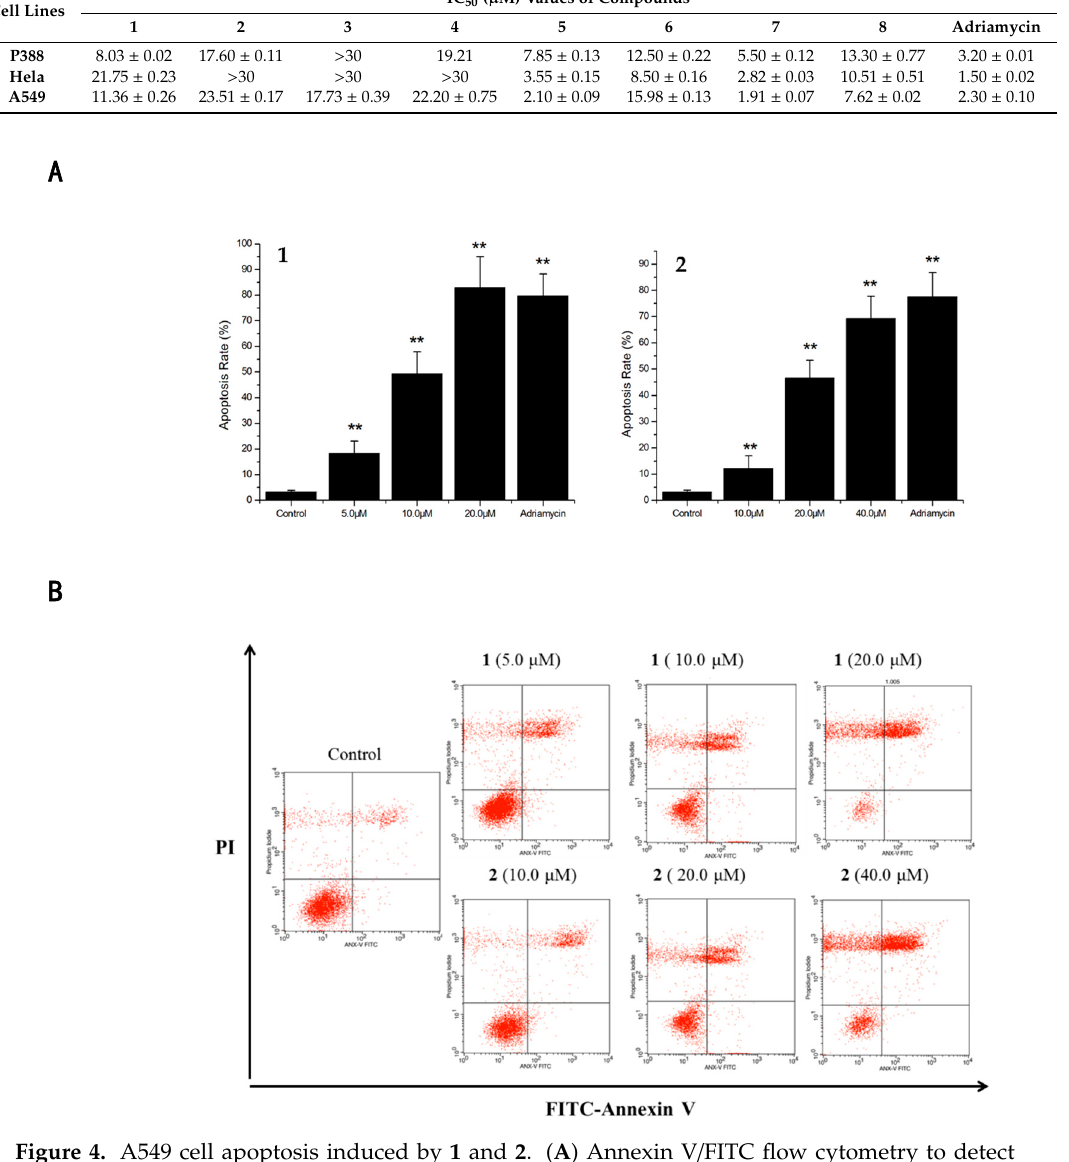
Figure 4. A549 cell apoptosis induced by 1 and 2 . ( A ) Annexin V / FITC flow cytometry to detect the effect of different concentrations of 1 (5, 10, 20 μ M) and 2 (10, 20, 40 μ M ) on apoptosis rate. n = 3, ** p < 0.01. ( B ) Apoptotic rates of A549 cells as induced by compounds 1 and 2, which were inspected by